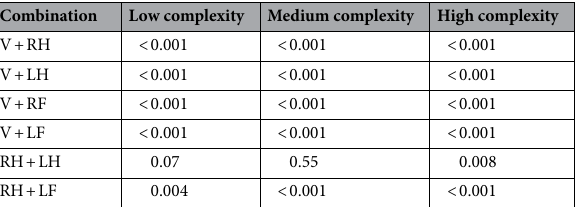
Table 1. Mid-p version of McNemar’s exact conditional test of the difference between dominant and non- dominant version of the different effector combinations. Table shows p-values of each test.